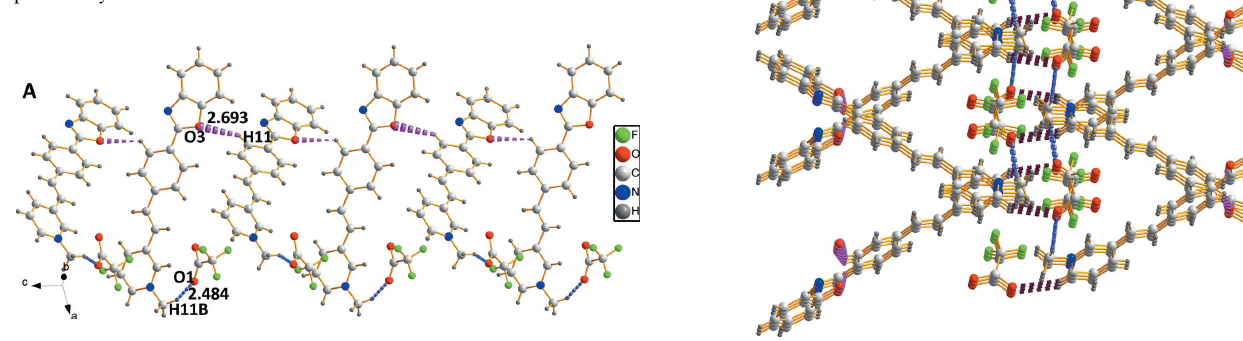
Figure 1 The molecular structure, with displacement ellipsoids drawn at the 50% probability level.